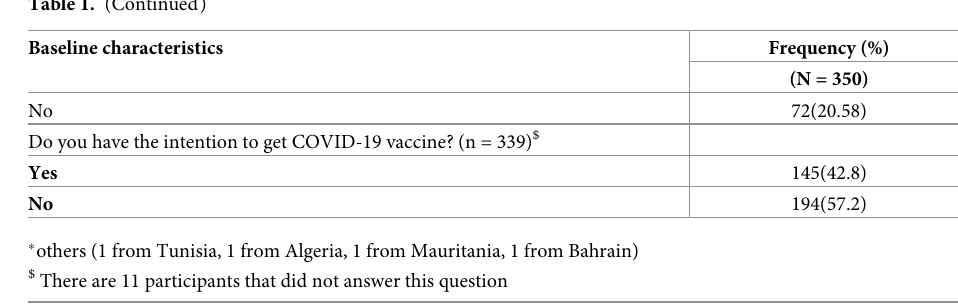
Reliability analysis. All sub-scales had a satisfactory internal consistency. Both ‘‘Confi- dence” and ‘‘Collective responsibility” sub-scales have Cronbach’s alpha of 0.829.‘‘ “Con- straints” sub-scale had the lowest Cronbach’s alpha (0.701) (Table 2). Concurrent validity. Table 3 showed that intention to get COVID-19 vaccine was pre- dicted by age as younger people (aged less than 40 years) were 85% more intended to get COVID-19 vaccine compared to older participants (OR: 1.85, 95%CI:1.07–3.21). The 5 C sub- scales were significantly predicting the intention to get COVID-19 vaccine as follows; confi- dence (OR: 1.15, 95%CI:1.07–1.69), complacency (OR: 0.91, 95%CI: 0.86–0.98), constraints Table 2. Descriptive statistics, reliability, and convergent validity of the Arabic version of the 5C scale. Variable Mean ± SD Item-mean score correlation